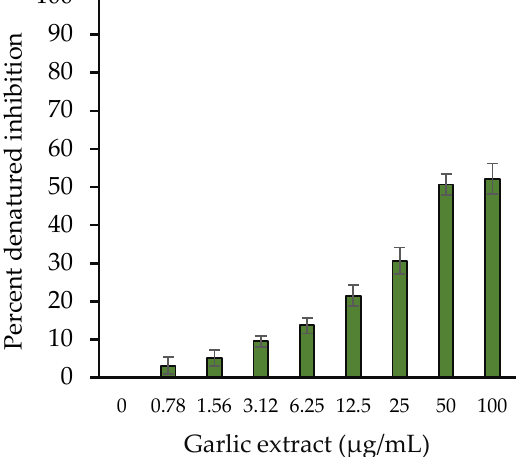
Figure 3. Percentage protection from denaturation induced by heat vs. garlic extract concentration (0–100 µ g/mL). The results are presented as means ± SEM ( n = 3). All the percentage denaturation inhibition results (0.78–100 µ g/mL garlic extract) were statistically significant compared with the sample without extract (0 µ g/mL). Comparison between two groups was performed based on t test, and significance was defined as p <